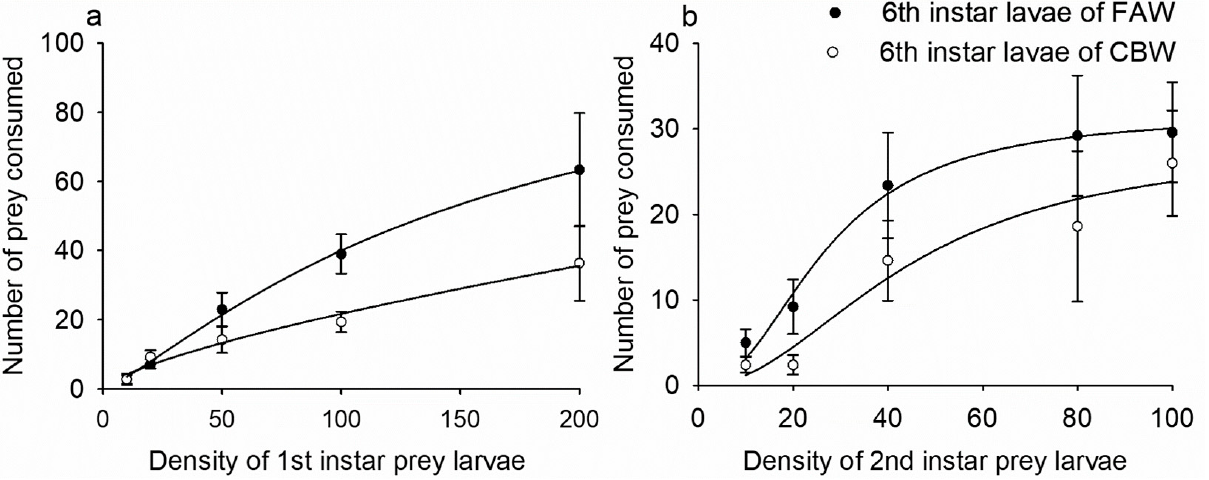
Figure 1. Photographs to show the bidirectional predation activity between Spodoptera frugiperda (FAW) and Helicoverpa armigera (CBW) larvae. ( a ) Sixth-instar larva of FAW preying on CBW. ( b ) Sixth-instar larva of CBW preying on FAW.